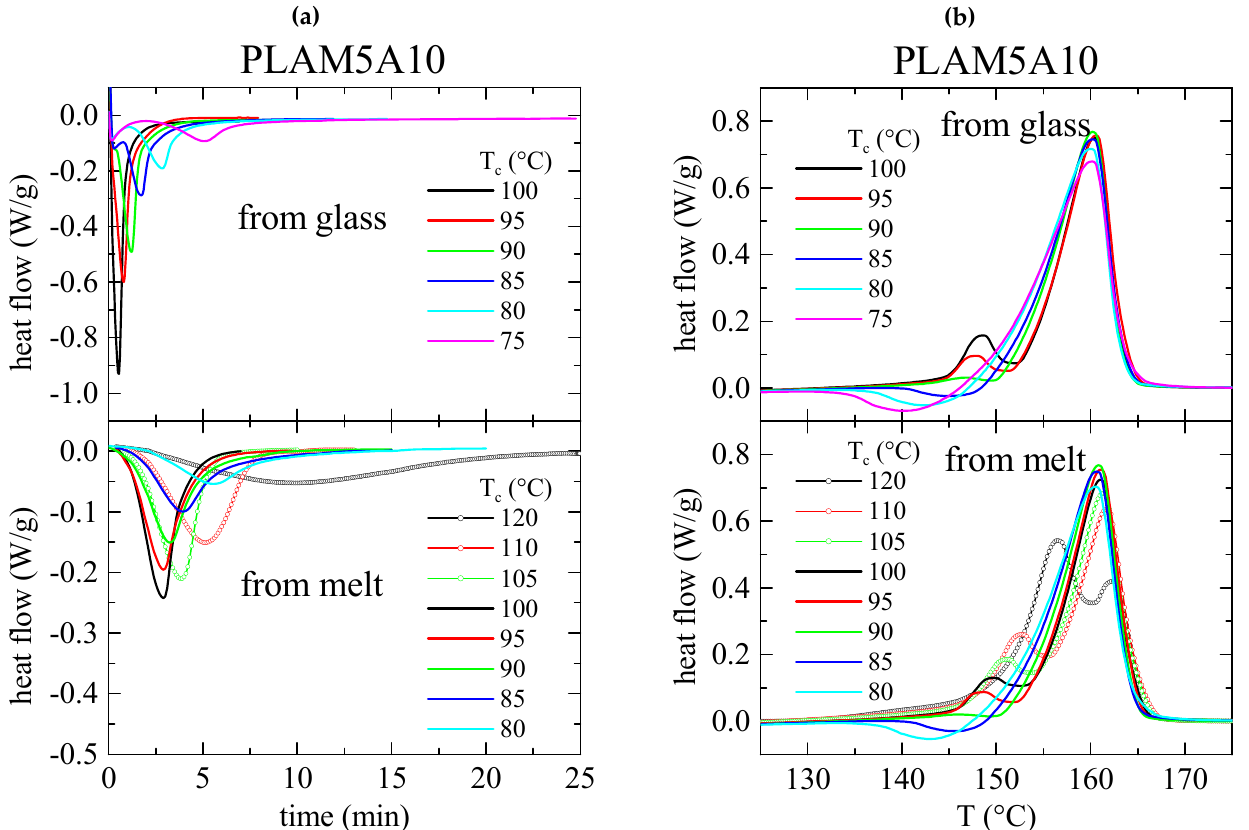
Figure 6. ( a ) Crystallization isotherms (exo down) for sample PLAM5A10, either from the glassy state or from the melt, and ( b ) subsequent heating curves (endo up), at 10 °C/min.